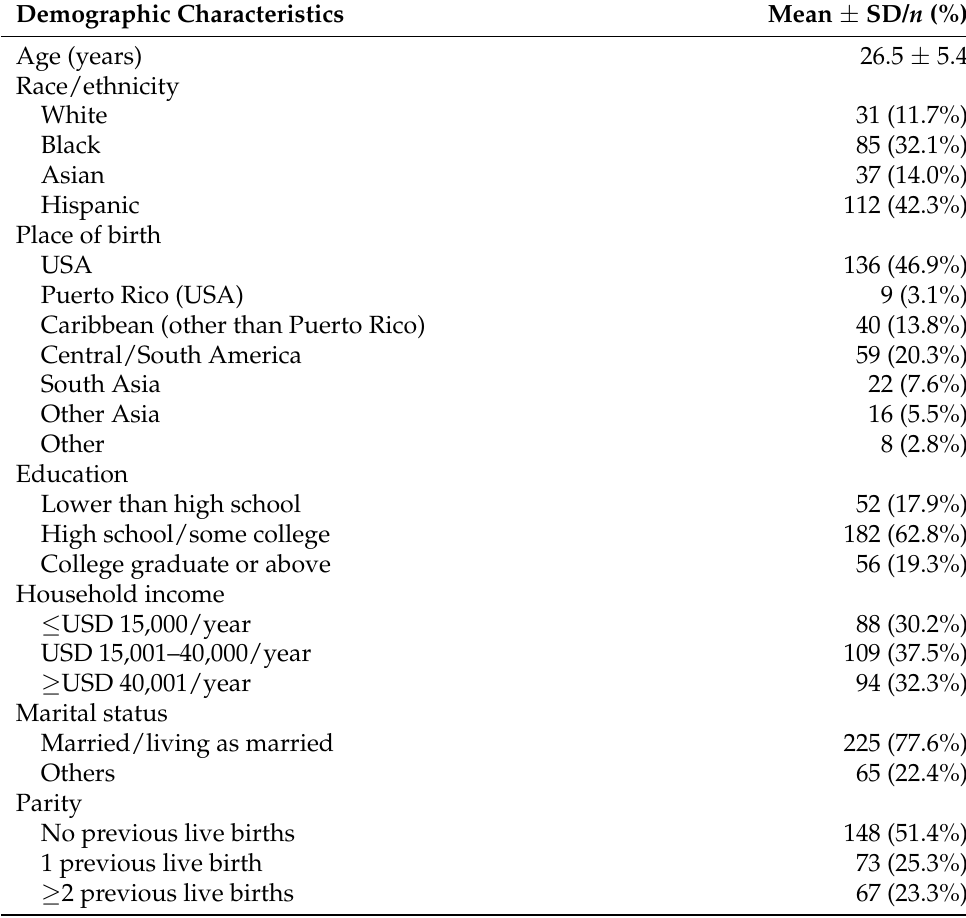
Table 1. Demographic characteristics of the study participants (N =